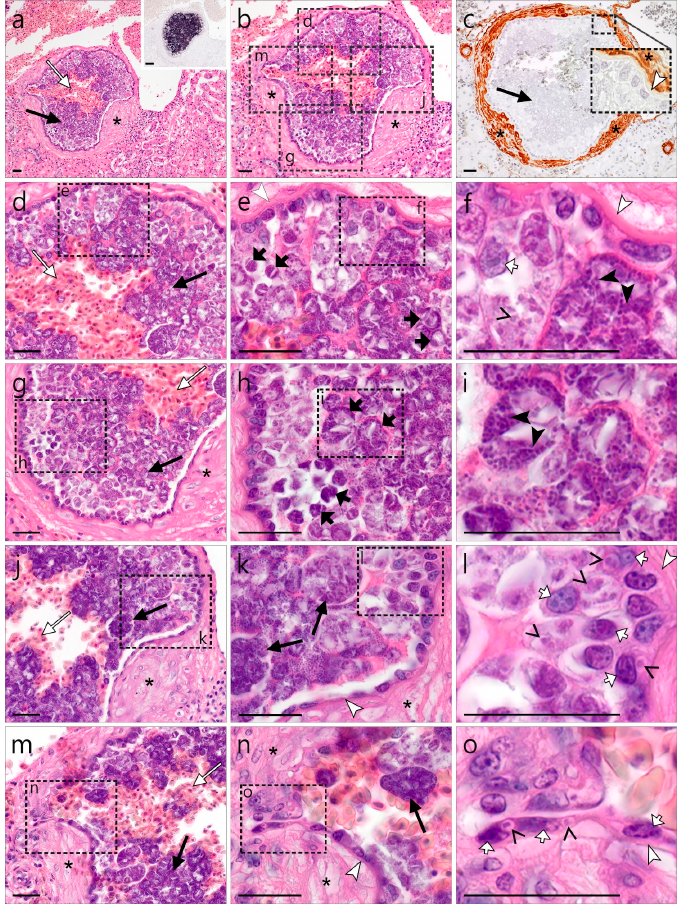
Figure 4. Leucocytozoon sp. (lineage STAL5) meronts in the kidney of a tawny owl ( Strix aluco ). A cluster of meronts morphologically similar to those observed in the brain was located in the renal